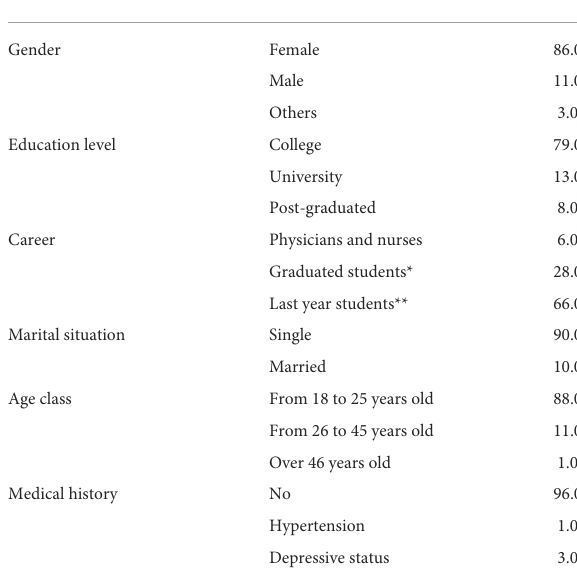
TABLE 1 General characteristics of study participant ( n = 100).